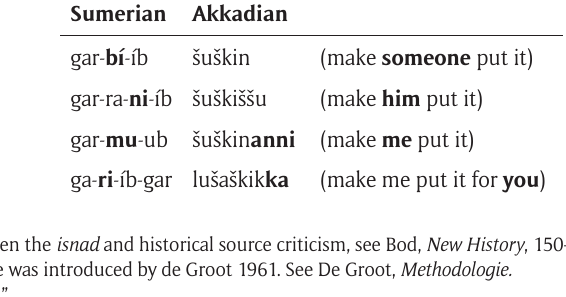
Table 1: Transcribed conjugations of the Sumerian verb gar (to put) with translations in Akkadian showing the discontinuous relations between gar and the affix ib . The conjugations are from clay tablet OBGT VI. Adapted from Huber, “Babylonian Understanding of Grammar: A Reexamination of OBGT VI-X.” Journal of Cuneiform Studies 59 (2007),